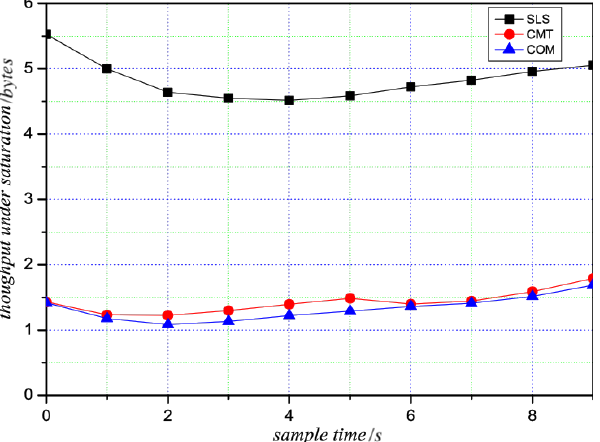
Figure 8. Throughput of the proposed method and other methods under